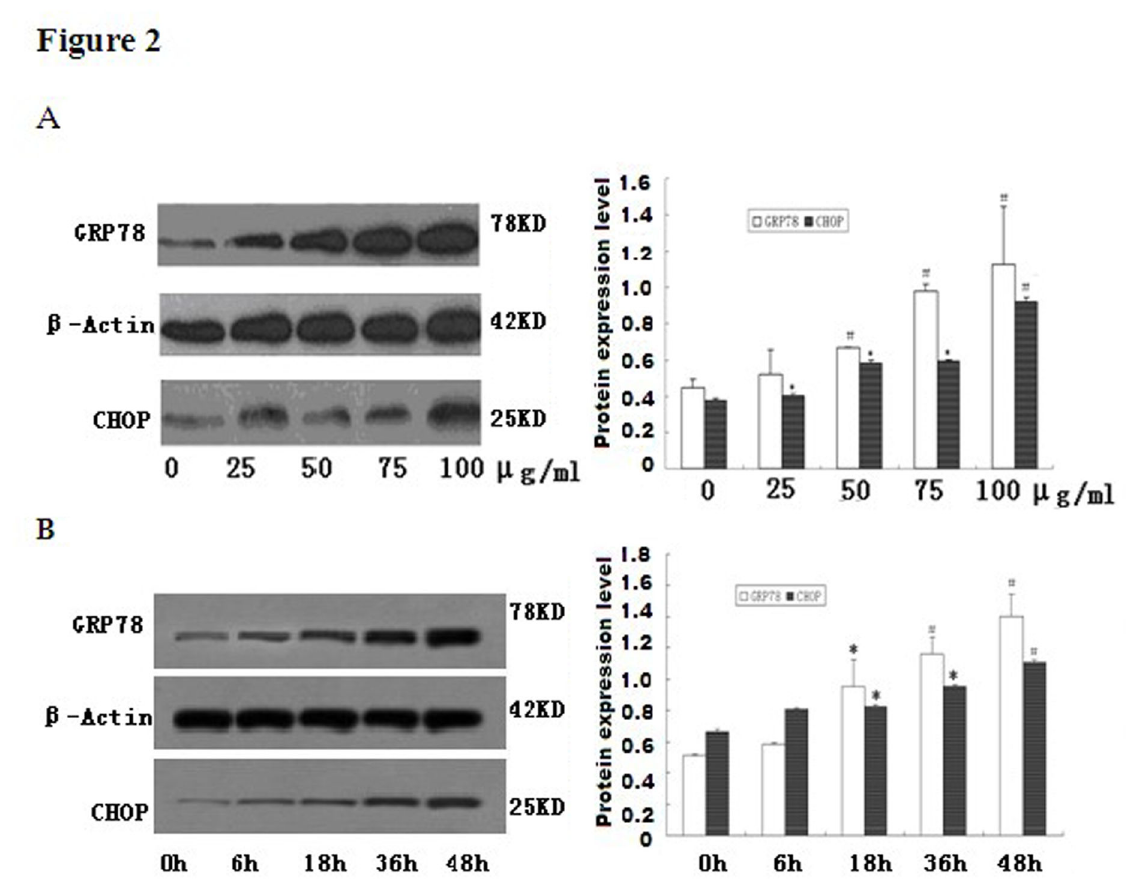
Figure 2. Free cholesterol induction of ER stress in adipocytes. Fully differentiated 3T3-L1 cells were incubated in the medium containing various concentration of ox-LDL (0-100µg/ml) with Sandoz 58035 for 48 hrs (A). Lane 1: control; lane 2: ox-LDL at 25μg/ml; lane 3: ox-LDL at 50μg/ml; lane 4: ox-LDL at 75μg/ml; lane 5: ox-LDL at 100μg/ml; Adipocytes were incubated with ox-LDL (50µg/ml) in a combination of Sandoz58035 for indicated times (0-48hrs) (B). Lane 1: control; lane 2: ox-LDL for 6h; lane 3: ox-LDL for 18h; lane 4: ox-LDL for 36h; lane 5: ox-LDL for 48h. GRP78 and CHOP expression was assessed by Western Blot andβ-actin was used as the housekeeping gene for normalization. Date is expressed as mean ±S.D from at least three independent determinations. * P<0.05, as compared with control; # P<0.01, as compared with control. doi: